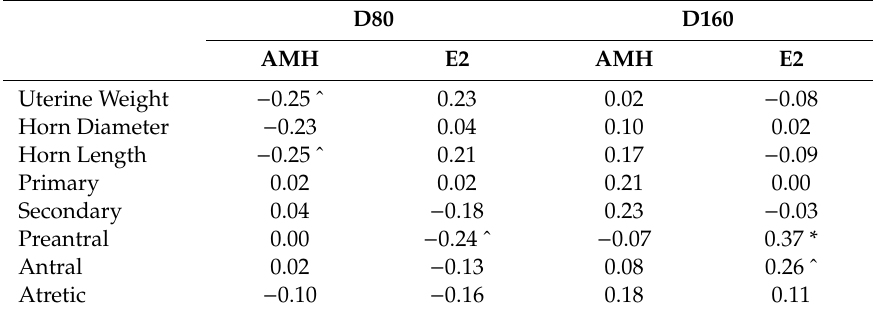
Table 2. Pearson’s correlation coe ffi cients between ovarian hormones at 80 and 160 days of age (D80 and D160, respectively) and uterine and ovarian traits at D160.